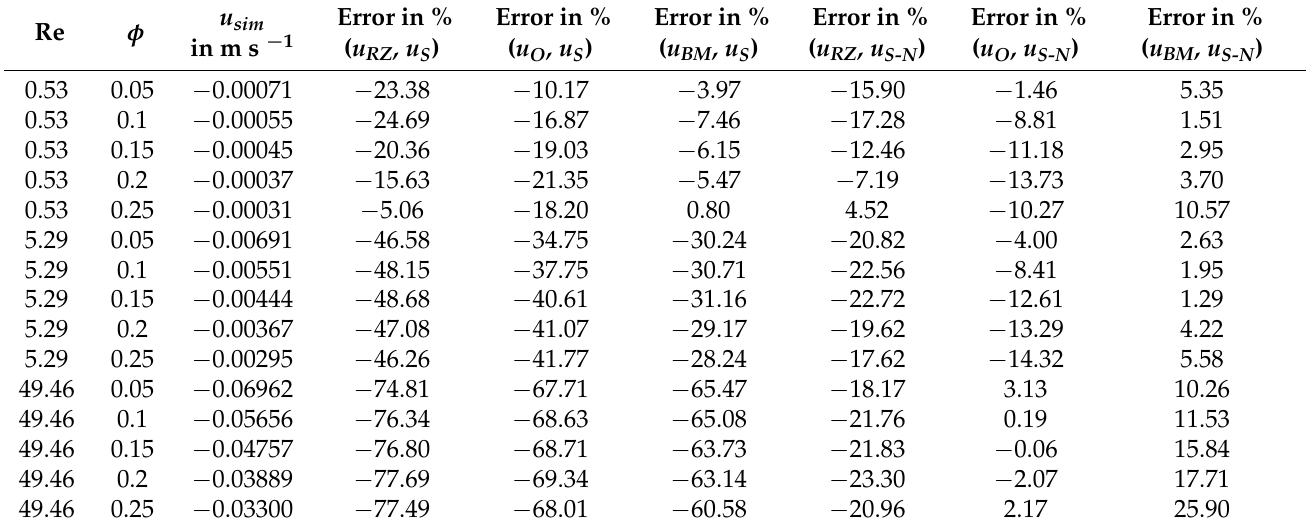
Table 9. Simulated hindered settling velocity regarding different Re and φ in comparison to different correlations.